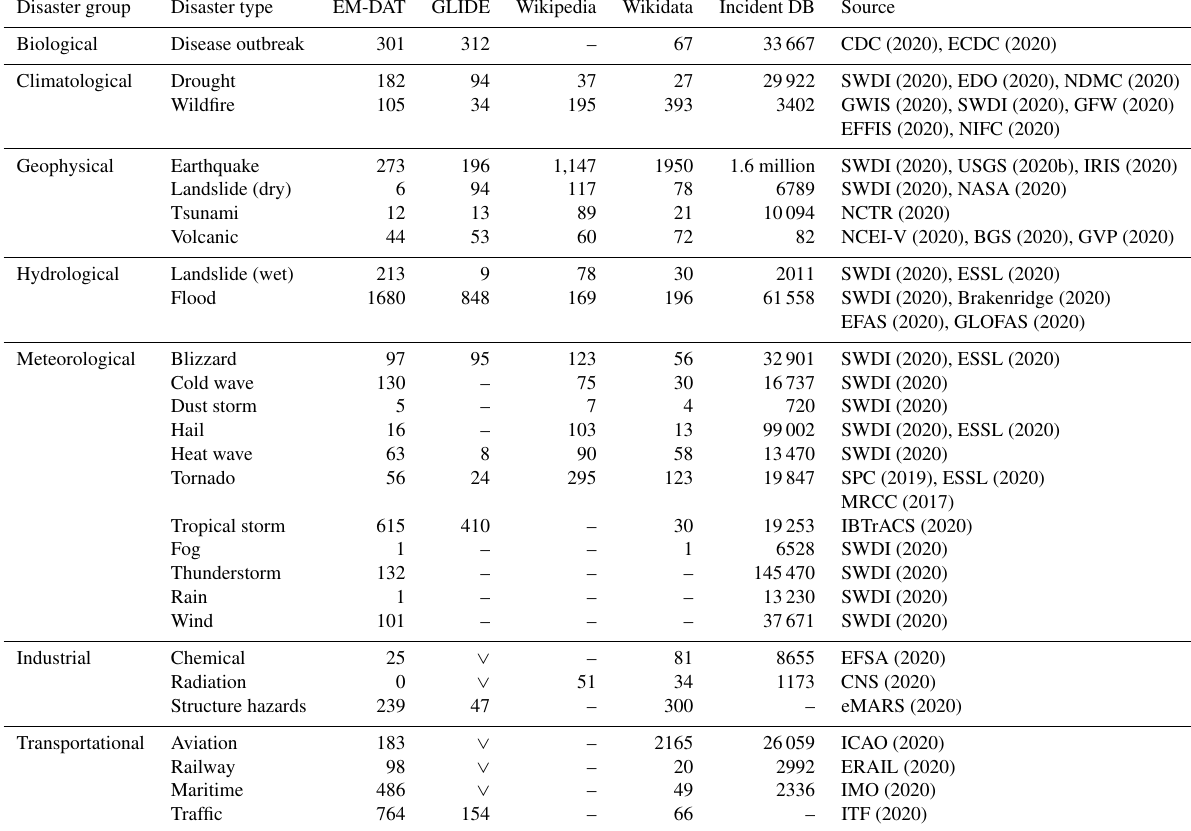
Table 1. List of disaster groups along with corresponding disaster types and numbers of corresponding disasters in EM-DAT, GLIDE, Wikipedia, Wikidata, and in 33 other incident databases (Incident DB) since 2008. Unavailable or not applicable information is marked with –, and ∨ denotes that the disaster counts are added to the disaster in the next row due to type